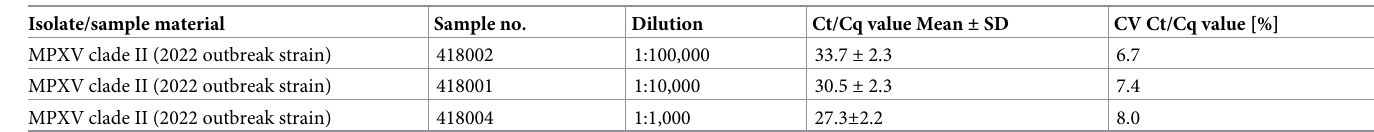
Table 4. Calculation of the scatter in Ct/Cq values for the MPXV positive samples. Isolate/sample material Sample no.